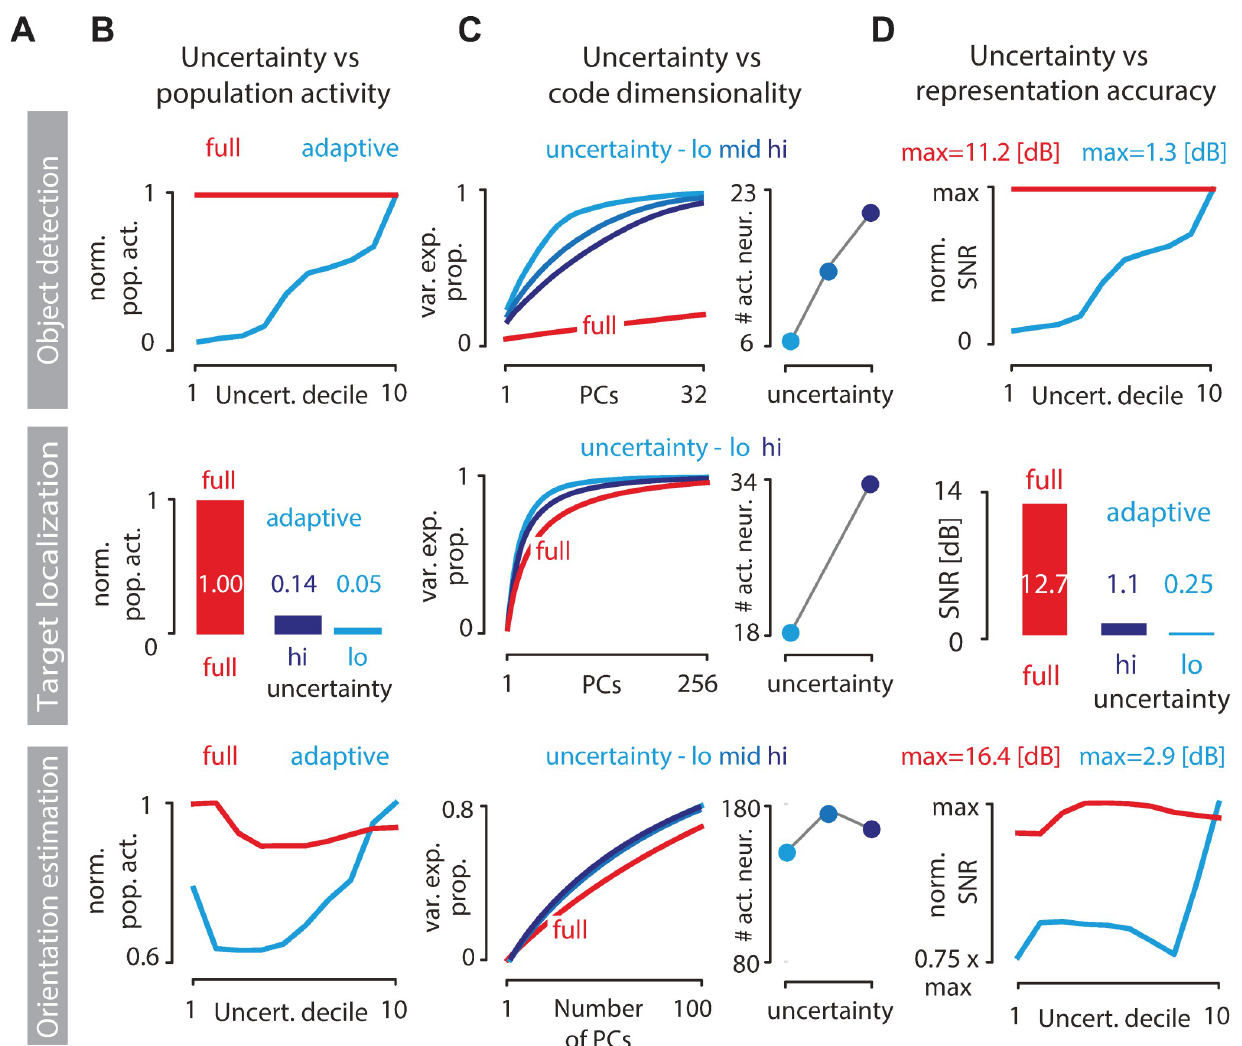
Fig 7. Predicted changes in the adaptive code when perceptual uncertainty is manipulated. (A) Rows correspond to inference tasks: object detection (top), target localization (middle), and orientation estimation (bottom). (B) Normalized population activity as a function of perceptual uncertainty for the standard sparse code (red = full code) and the adaptive code (blue). Uncertainty in object detection (top) and orientation estimation (bottom) tasks was binned into deciles (see Methods). Uncertainty in the target localization task (middle) is plotted for two levels of measurement noise (dark blue = high noise; light blue = low noise). (C) Dimensionality of the adaptive code can increase with increasing perceptual uncertainty (left column). Shown is the proportion of variance in total neural activity explained as a function of the number of principal components (red = full code; light blue = adaptive code at low uncertainty; medium blue = adaptive code at intermediate uncertainty; dark blue = adaptive code at high uncertainty; see Methods). Increase in code dimensionality is correlated with the number of active neurons at different levels of uncertainty (right column). (D) Same as (B) but showing the normalized SNR of the image reconstruction at different perceptual uncertainty